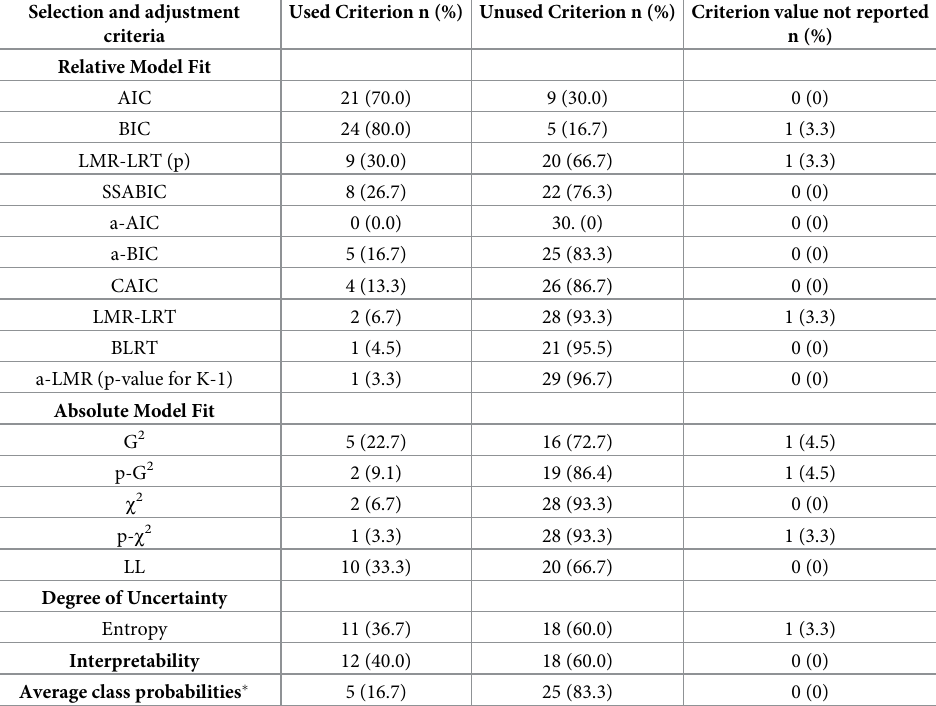
Table 4. Descriptive analysis of the criteria used by the articles (n = 30) to select the best fit LCA model. Selection and adjustment